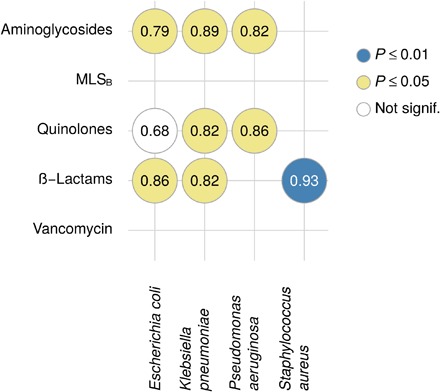
Association between the relative abundance of ARGs in UWTP effluents (aggregated by drug classes) and country-level data on phenotypic resistance of clinical isolates [data from EARS-Net,].(31) Numbers represent Spearman’s rank correlations; color codes indicate statistical significance. No statistically significant correlations were observed for Acinetobacter spp., Enterococcus faecium, or S. pneumoniae.